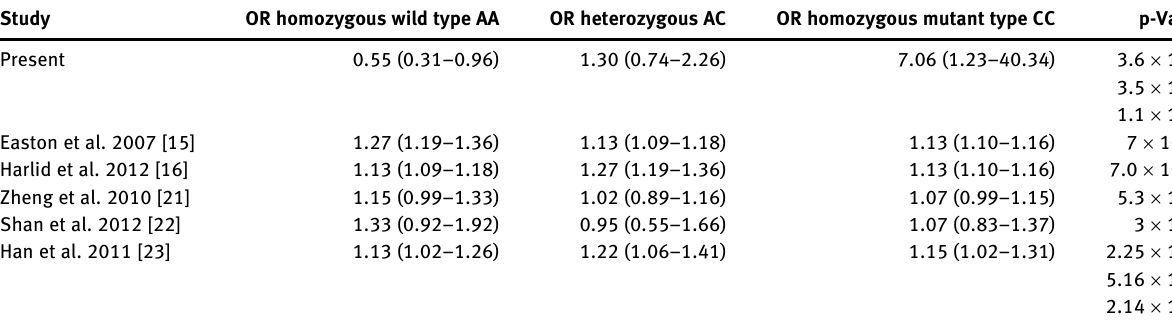
Table  : Population based comparative analysis of rs  SNP. Study